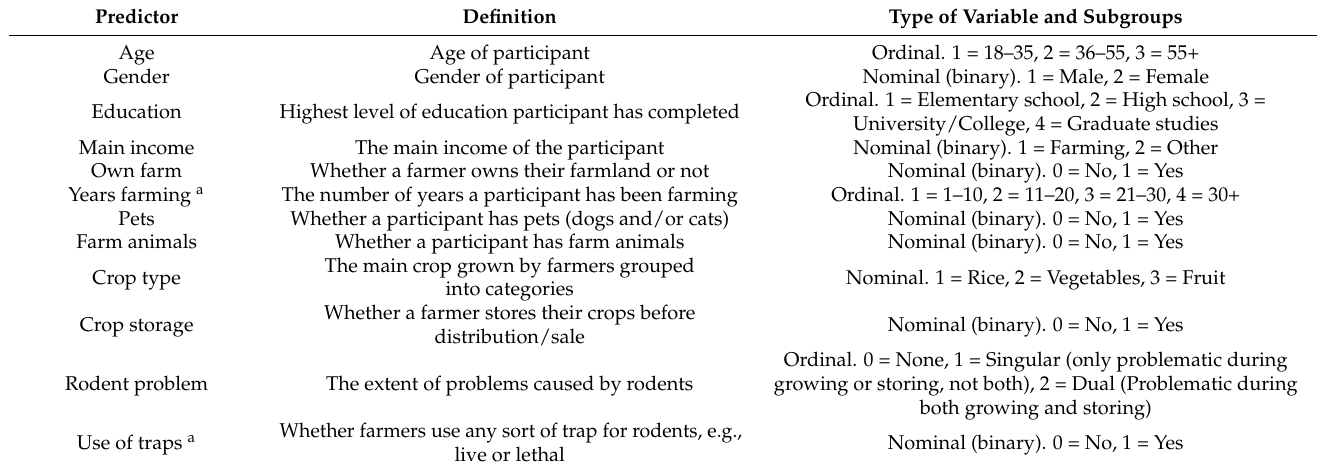
Table 1. Definitions for predictor variables associated with sociodemographic factors and farming practices of participants.